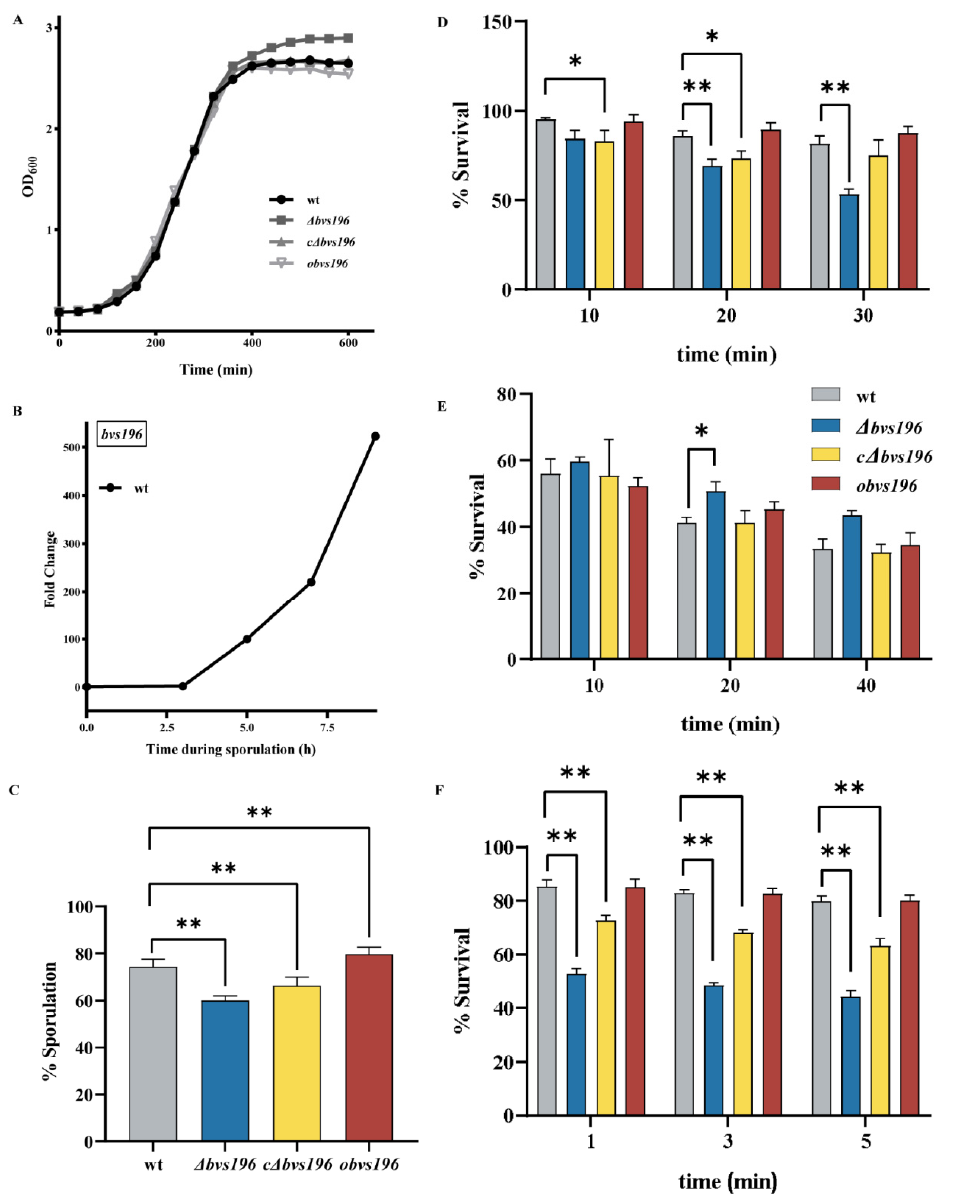
Figure 4. Transcriptional level of bvs196 and knock-out of bvs196 led to change in resistance in B. velezensis strain PEBA20. ( A ) Growth curves of wild-type strain wt, ∆ bvs196 , c ∆ bvs196 , and